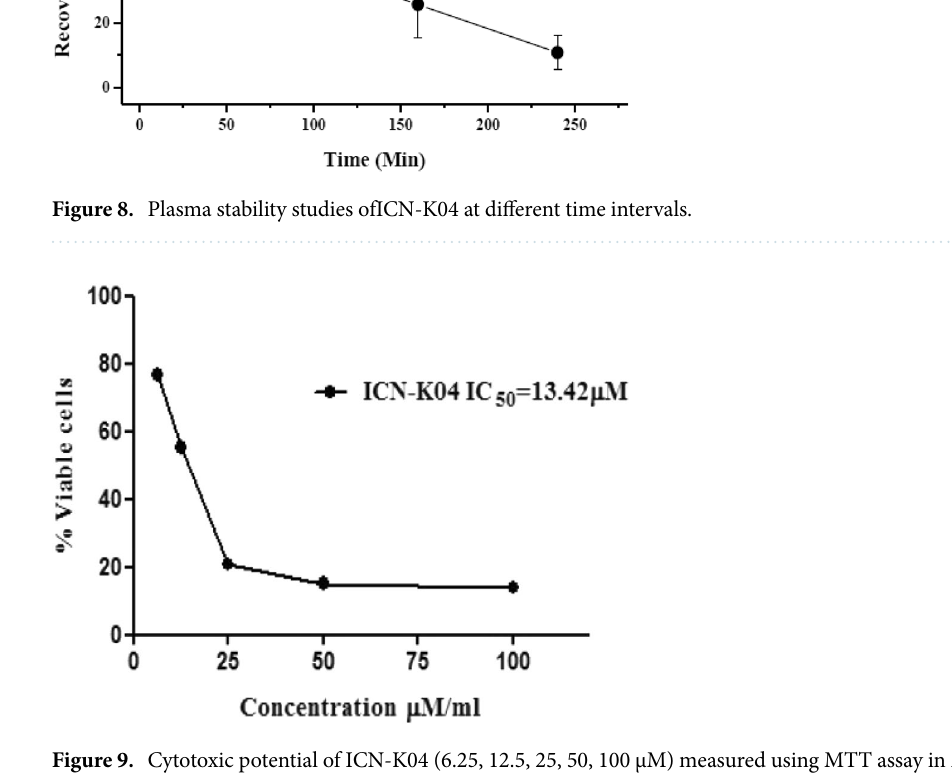
Figure 9. Cytotoxic potential of ICN-K04 (6.25, 12.5, 25, 50, 100 μM) measured using MTT assay in A549 cells for 24 h. The half-maximal inhibitory concentration (IC50) is obtained at 13.42 μM and error bars represent the mean ± SEM of three independent